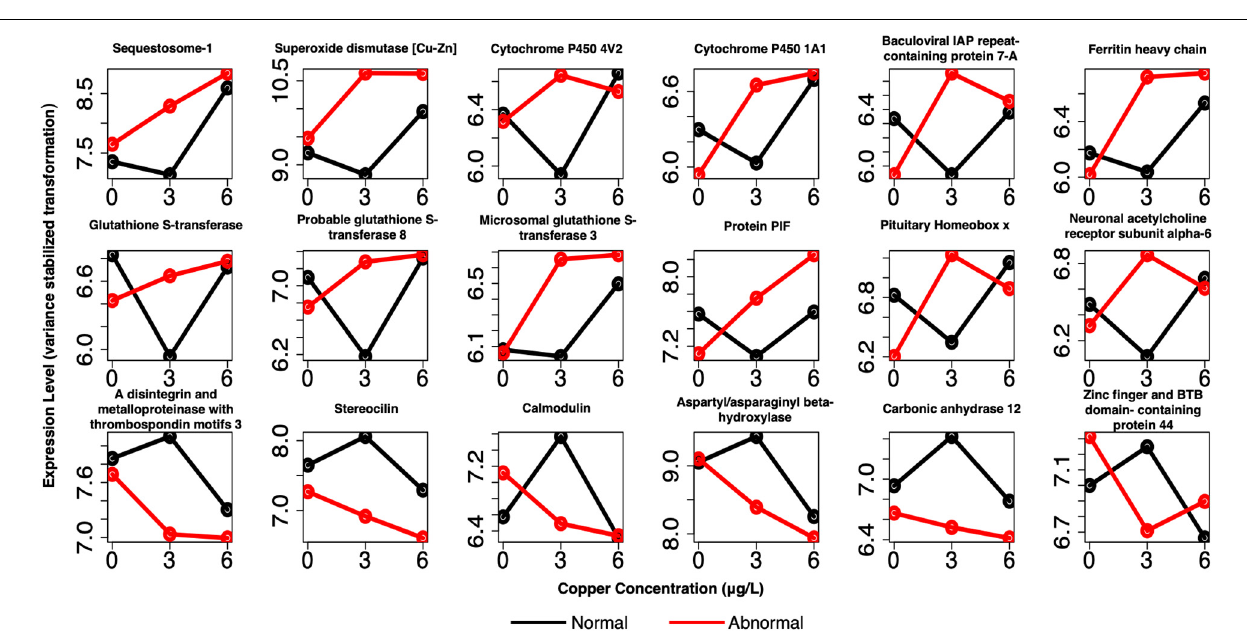
FIGURE 9 | Example profiles of pooled markers of effects at 3 µ g/L copper. Genes are related to apoptosis, oxidative stress, shell formation, development, cell adhesion, and divalent cation binding. Red lines depict expression of abnormal animals, and black lines depict expression of normal